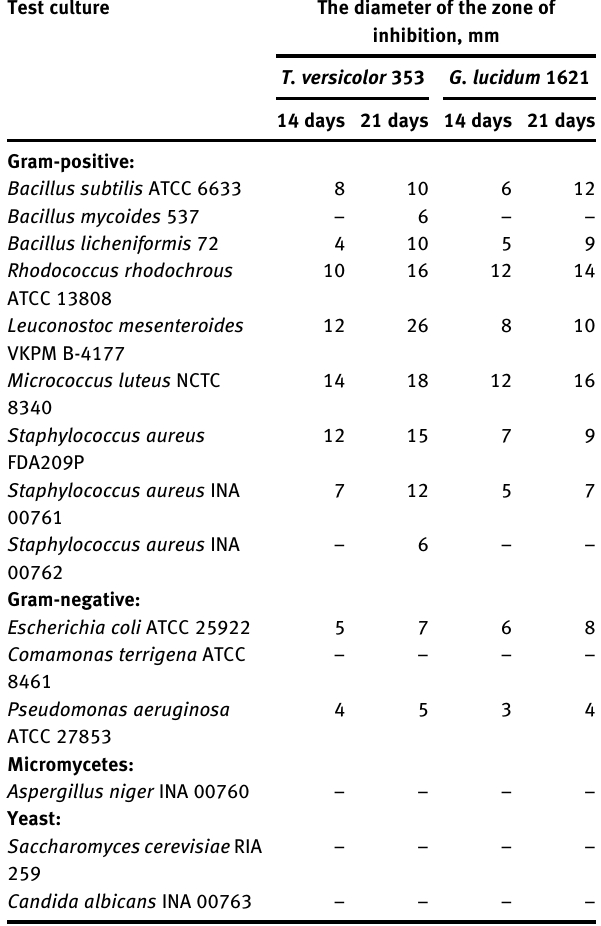
Table  : Antioxidant activity of the culture fl uid and biomass of G. lucidum  and T. versicolor  .